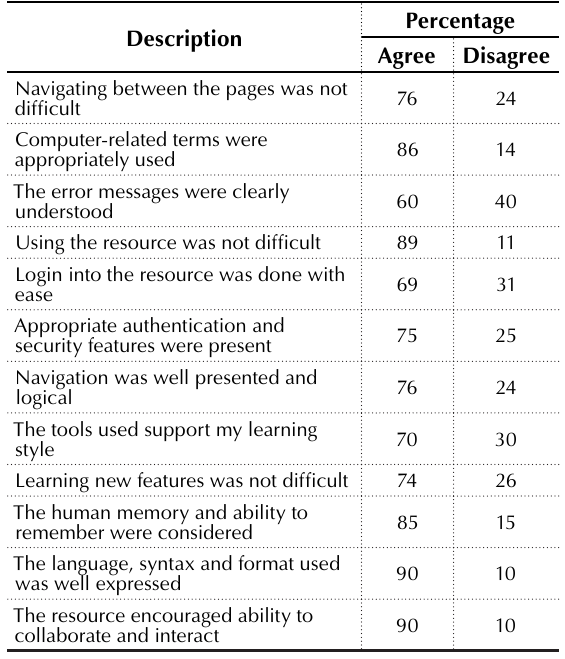
Table 1. Percentage (rounded) frequencies of